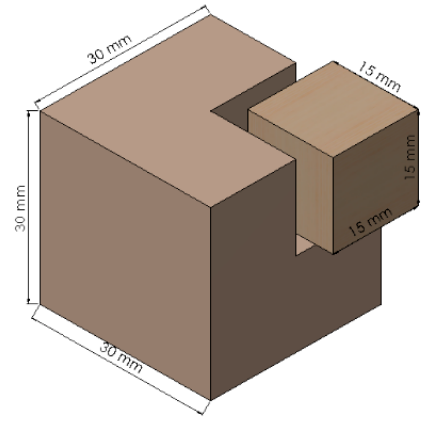
Figure 2. Dimensions of the treated sample and of the section selected for analysis.